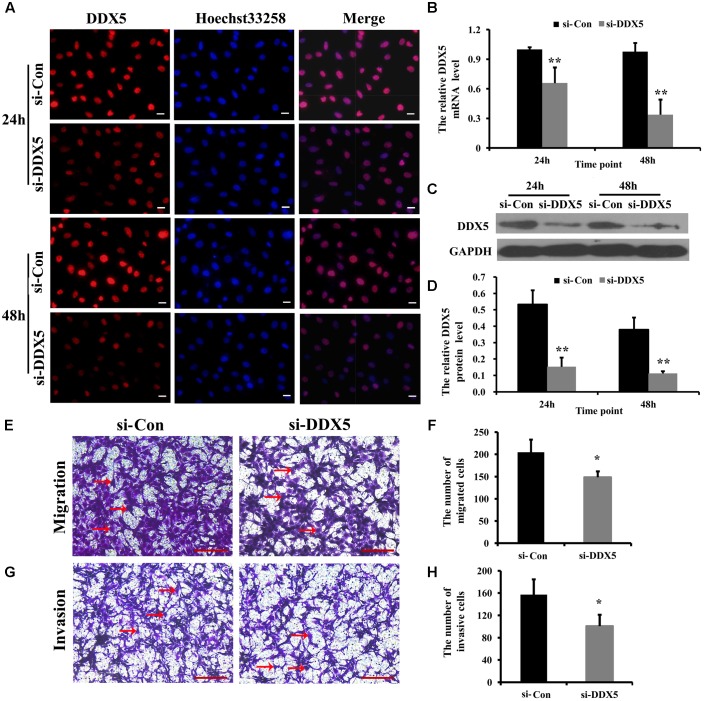
Knockdown of DDX5 inhibited the migration and invasion of MG63 cells. (A) Expression of DDX5 detected by immunofluorescence at 24 and 48 h after transfection with DDX5 siRNA (si-DDX5) or the negative control (si-Con), bar = 20 μm. (B) Data represent means ± SD of the relative DDX5 mRNA levels detected by qRT-PCR. (C) Expression of DDX5 detected by Western blot at 24 and 48 h after transfection with si-DDX5 or si-Con. (D) Data represent means ± SD of the relative DDX5 protein level. (E) Migrated cells of DDX5 siRNA group decreased compared with si-Con. Arrows indicates the migrated cells, bar = 200 μm. (F) Bar chart showed the average number of migrated cells. (G) Invasive cells of DDX5 siRNA group decreased compared with Control group. Arrows indicates the invasive cells, bar = 200 μm. (H) Bar chart showed the average number of invasive cells. ∗P < 0.05, ∗∗P < 0.01 vs. si-Con.